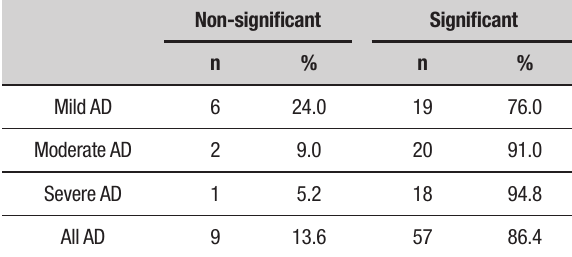
Table 4. Distribution of anxiety levels of family caregivers according to BAI 8 São Carlos-SP, 2015.